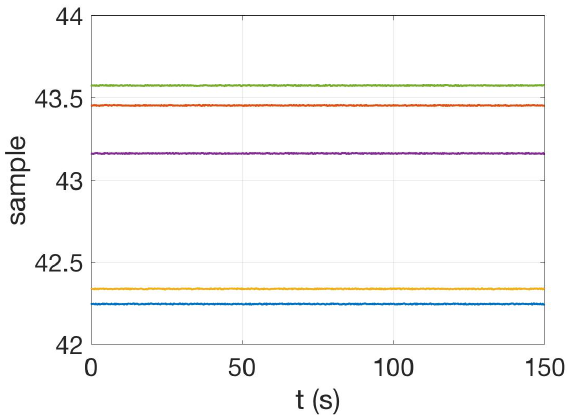
Figure 5. Samples with constant correlation function, r xx = const .